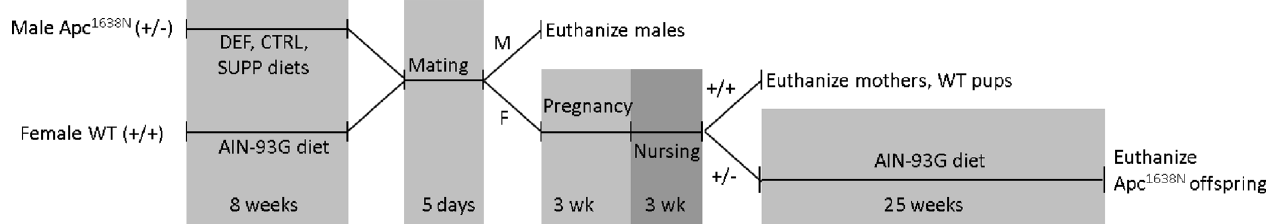
Fig 1. Design of animal experiment. Apc1638N (+/ − ), mice heterozygous for truncation mutation in the Apc gene; WT (+/+), C57BL6/J mice wild-type for Apc gene; DEF, B-vitamin deficient; CTRL, B-vitamin replete; SUPP, B-vitamin supplemented; M, male; F,